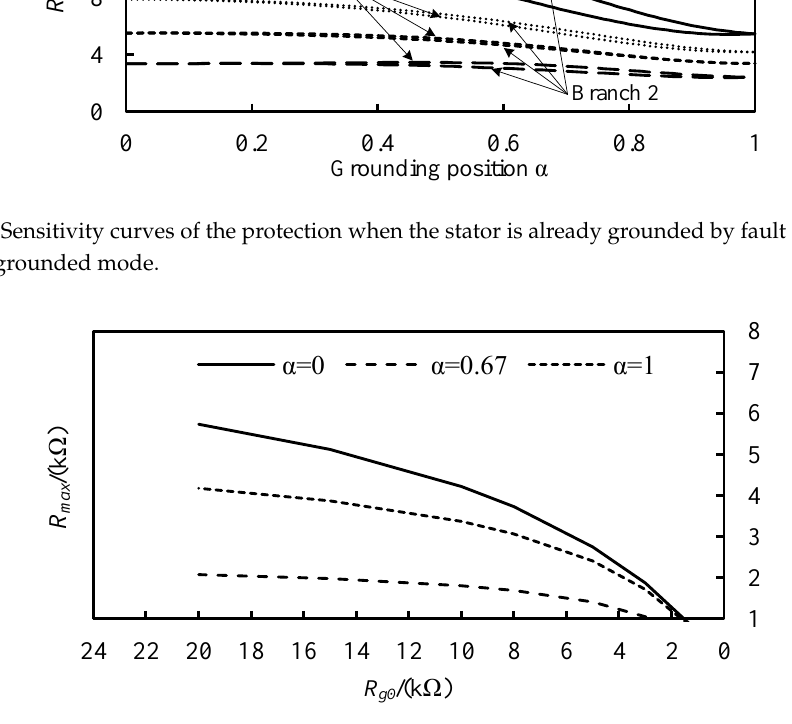
Figure 6. Sensitivity curves of the protection when the stator is grounded by a slowly reduced resistor in the ground transformer grounding mode.